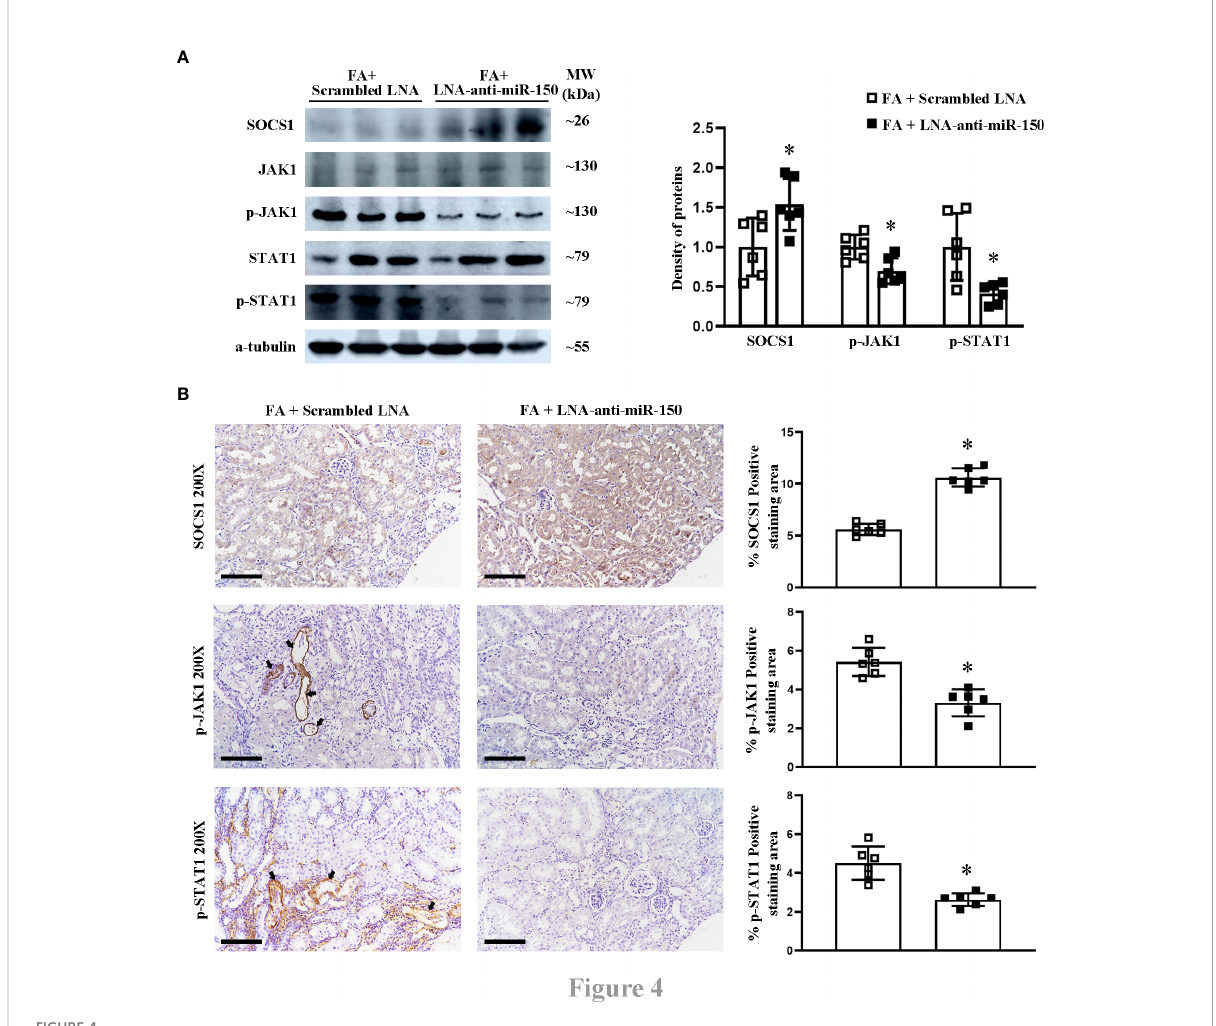
FIGURE 4 The effect of LNA-anti-miR-150 on the protein expression of SOCS1/JAK1/STAT1 pathway in renal interstitial fi brosis mice. Western blotting (A) demonstrated the renal protein levels of SOCS1, JAK1, p-JAK1, STAT1, and p-STAT1 and the density of the blots. Immunohistochemical (IHC) staining (B) of SOCS1, p-JAK1, and p-STAT1 and the percentage of positive-staining area of each of the abovementioned proteins are shown. For immunohistochemical staining, magni fi cation = ×200, scale bar = 100 m m. For all graphs, data are presented as mean ± SD, n = 6. * p < 0.05, FA + LNA-anti-miR-150 group vs. FA + scrambled LNA